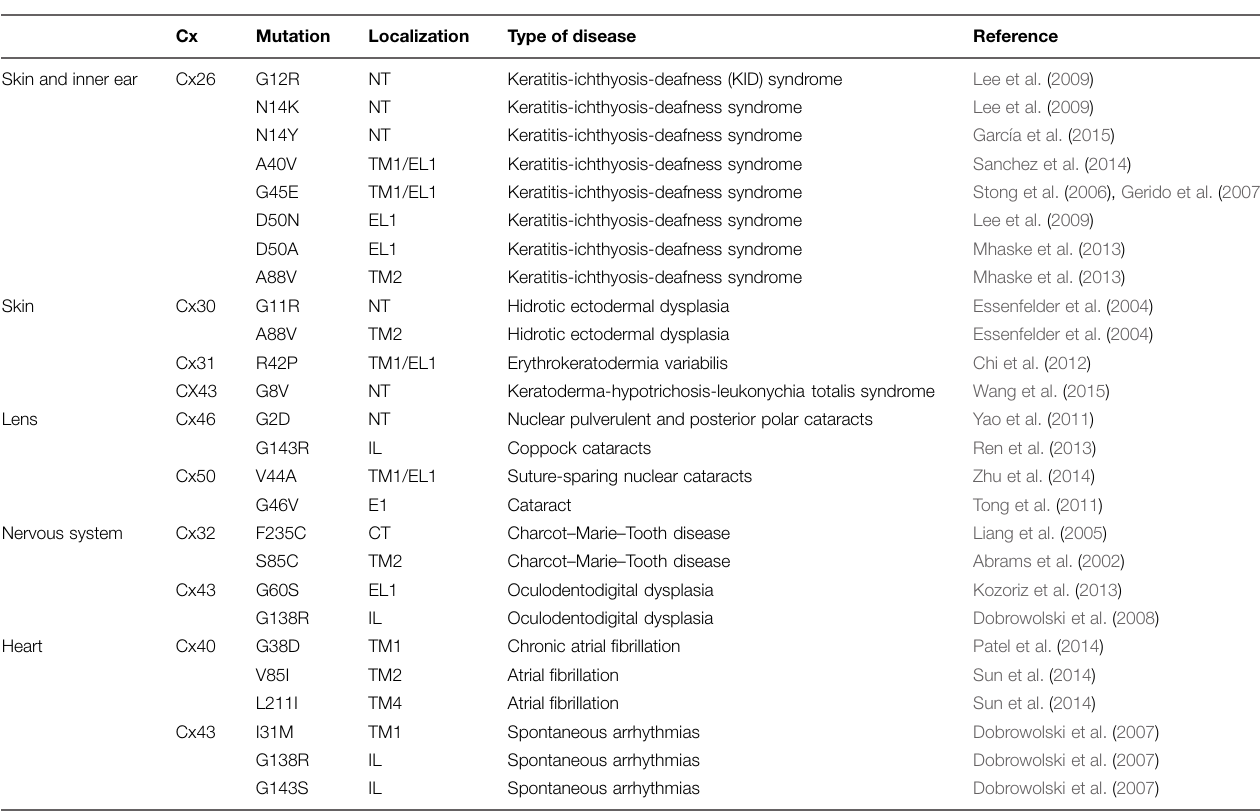
TABLE 1 | Connexin (Cx) mutations associated to leaky